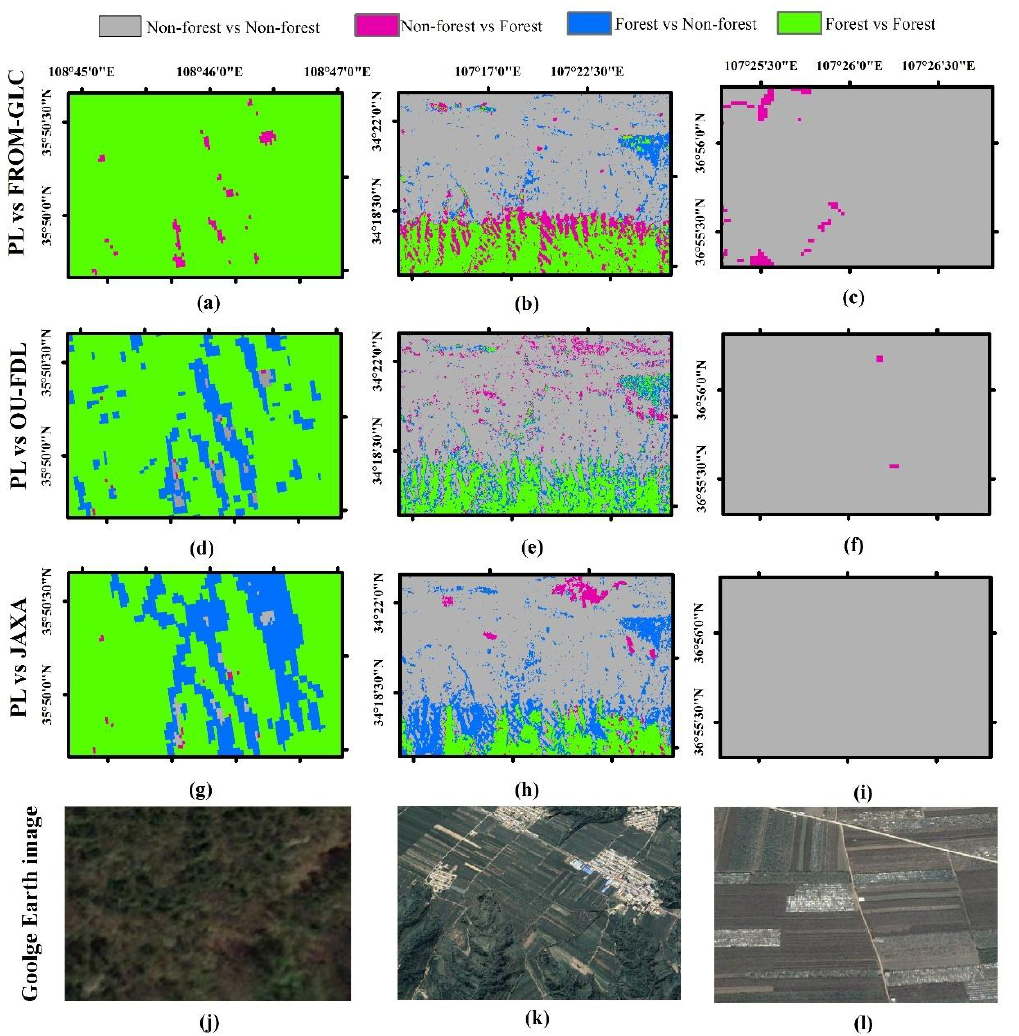
Figure 9. Zoom-in windows of the spatial comparison between the PALSAR/Landsat forest map and FROM-GLC forest map ( a , d , g , j ); OU-FDL forest map ( b , e , h , k ); and JAXA forest map ( c , f , i , l ) in 2010.